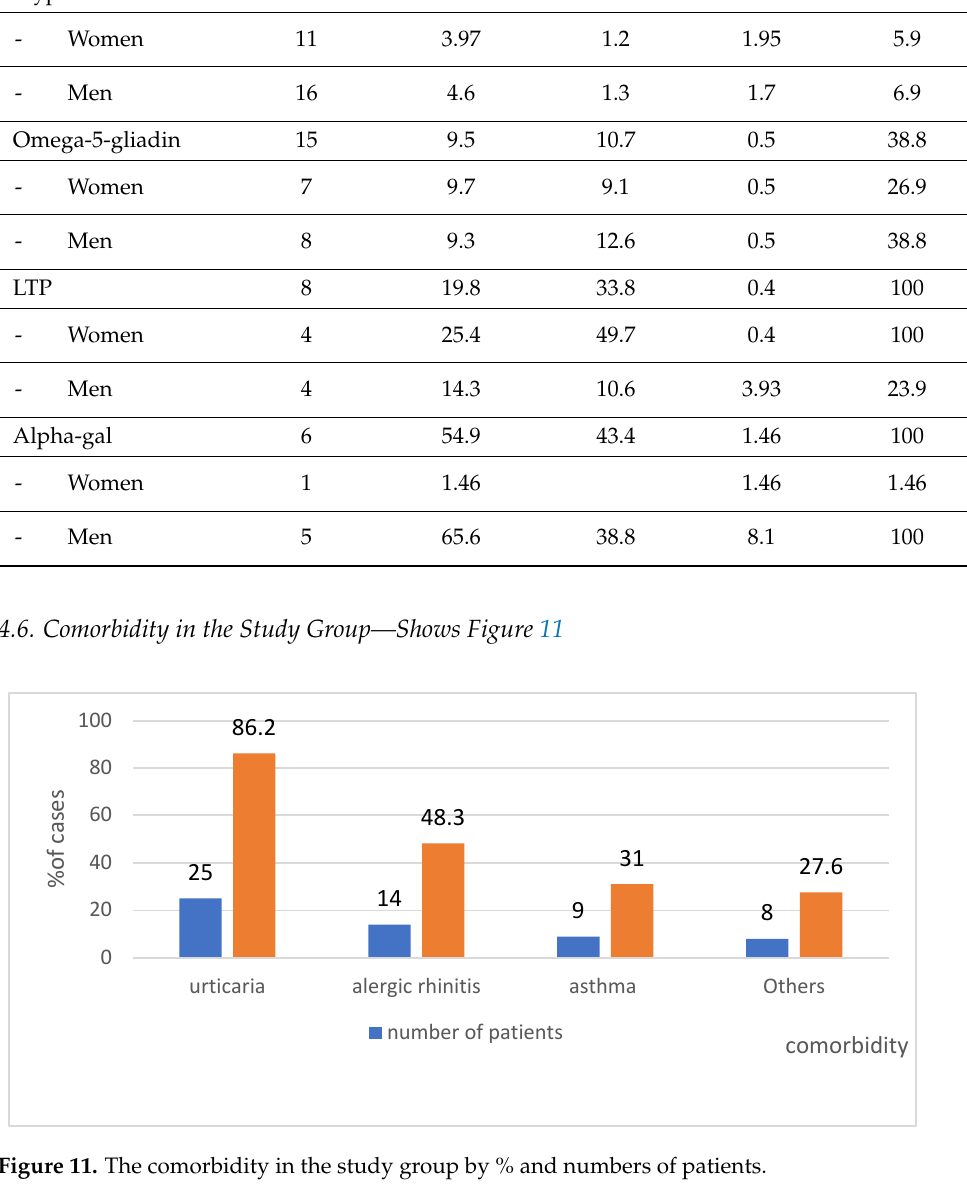
Table 2. The characteristics of sIgE values and tryptase in the study group ( n = 29) with division by gender.